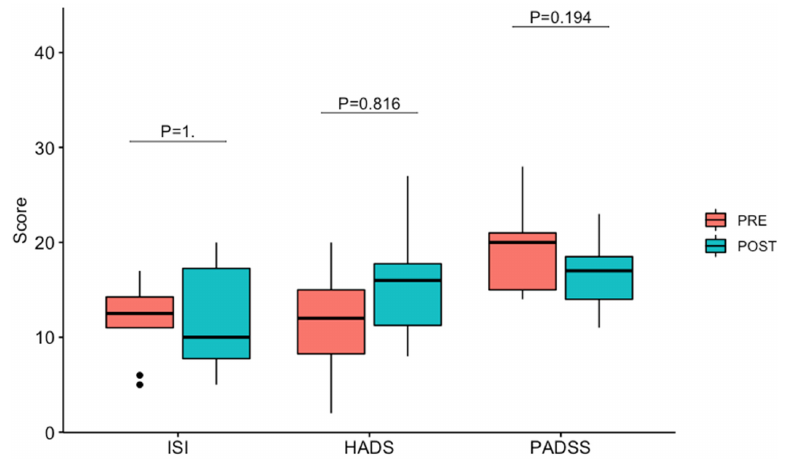
Figure 2. Box plot of Assessment Score for PRE and POST scores for ISI, HADS and PADSS (note: p values are from Wilcoxon tests). PRE: after CBT-NREMP intervention; POST: follow-up. Box represents the 50% of the central data (between 25th and 75th percentiles), with a line inside that represents the median. Dots represent points outside 1.5 times the interquartile range above the upper quartile and below the lower quartile.